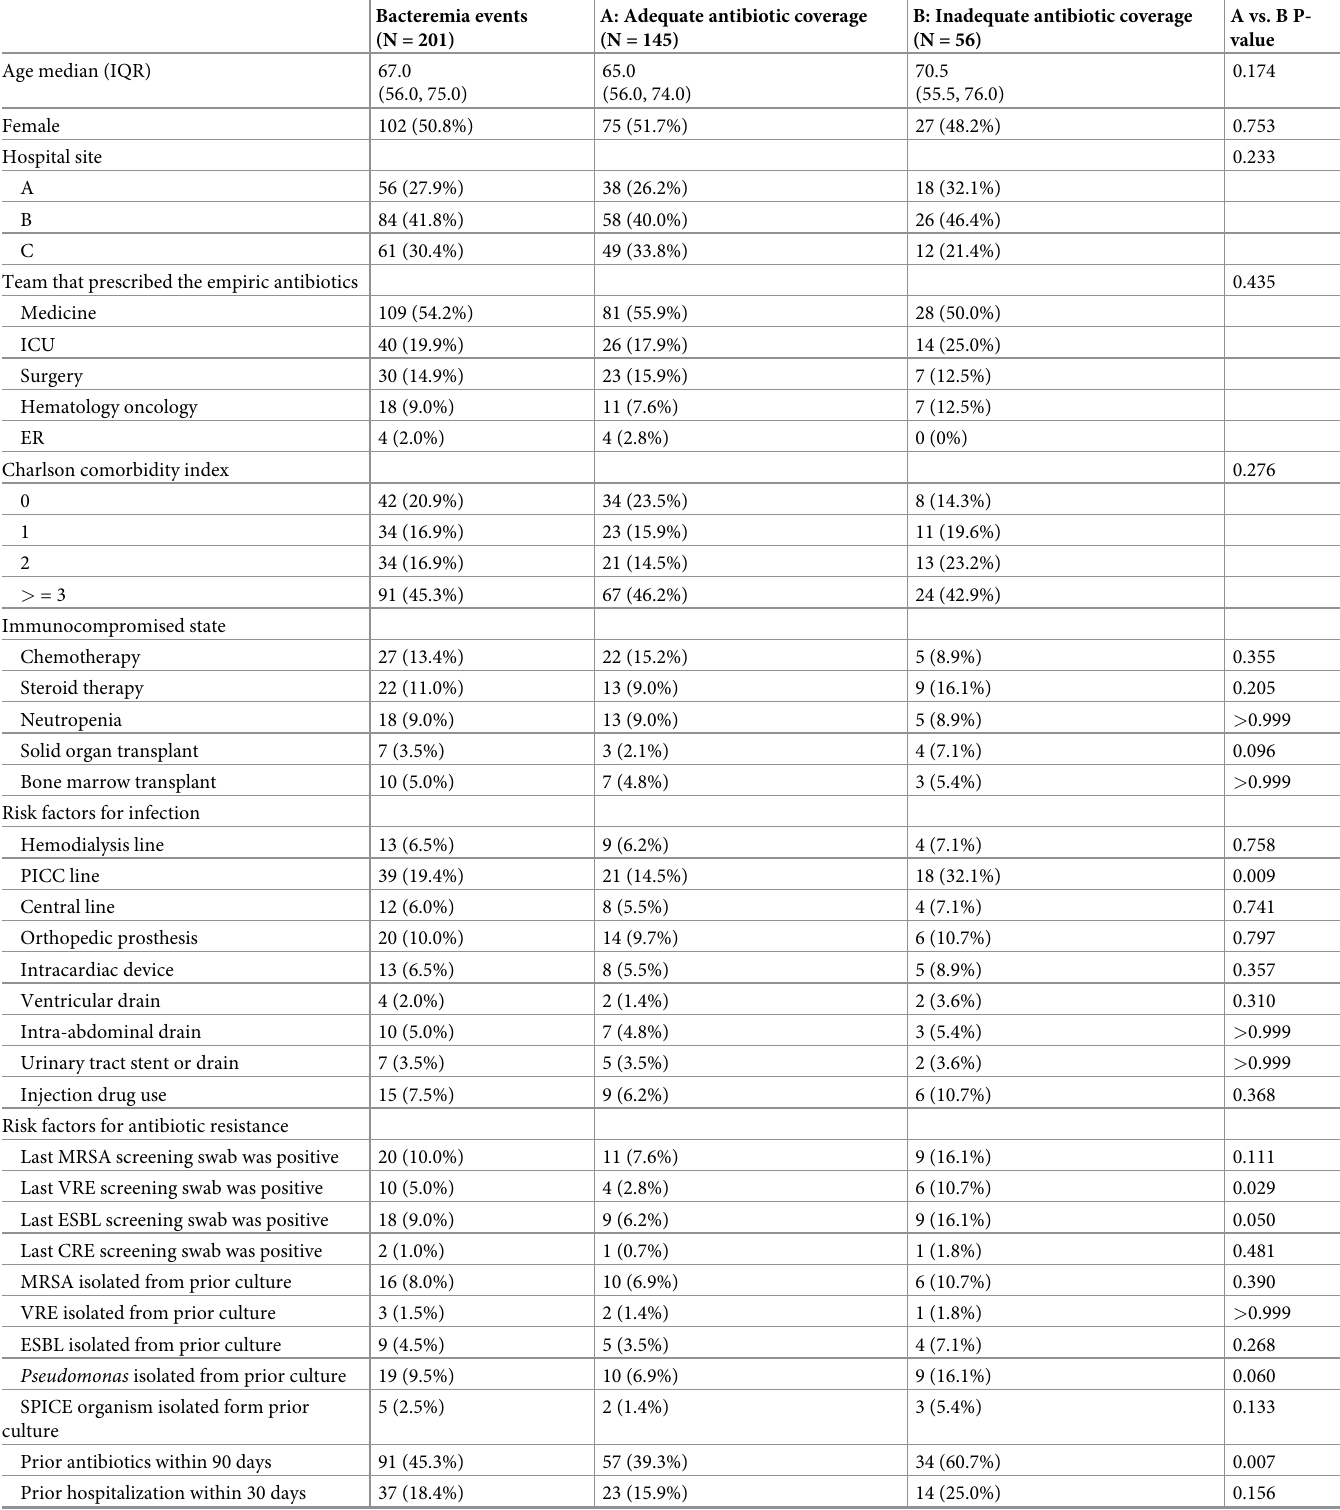
Table 2. Baseline characteristics and outcomes of patients with